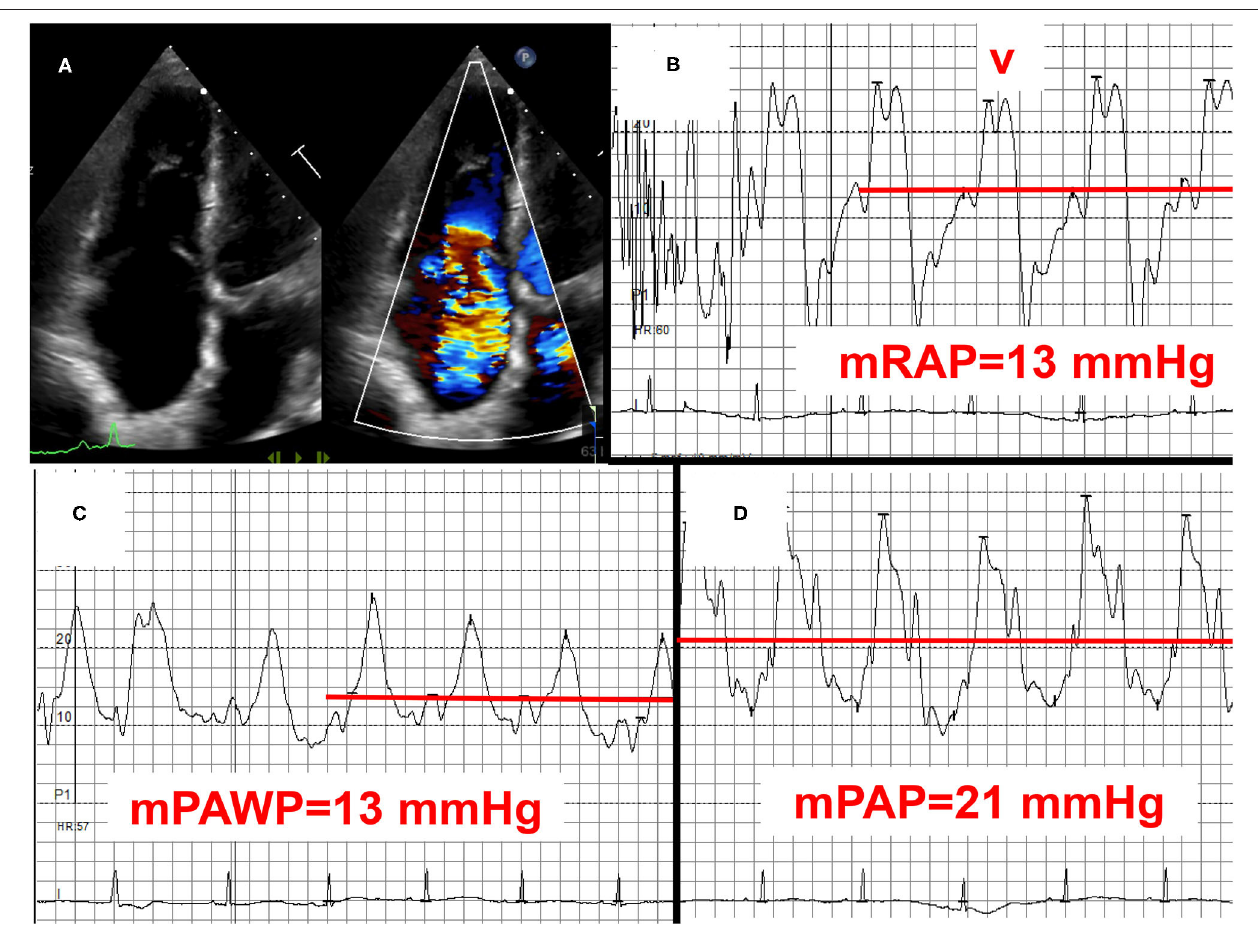
FIGURE 6 | Example 3 of a patient with a mid-range left ventricular ejection fraction (LVEF) and pulmonary hypertension (PH): 83-year old female with permanent atrial fibrillation, previous aortic valve replacement, and coronary artery disease. LVEF 45%, normally functioning aortic bioprothesis, mild to moderate mitral regurgitation, and severe tricuspid regurgitation (A) with signs of right heart failure and high right atrial pressure with high V waves (B) . Mean pulmonary artery wegde pressure (mPAWP): 13 mmHg (C) , mean pulmonary artery pressure (mPAP): 21 mmHg (D) . After coronary angiography (50ml of contrast) rise in mPAWP to 18 mmHg and mPAP to 26 mmHg. The patient has occult post-capillary PH (2016 ESC/ERS definition)/mild post-capillary PH (2018 definition) in the context of left ventricular systolic and diastolic dysfunction. The relatively mild extent of PH does not fully explain right ventricular dilation and severe tricuspid regurgitation. Severe tricuspid regurgitation is most likely the effect of atrial fibrillation predominantly affecting the tricuspid annulus. Management with loop diuretics and spironolactone. The role of transcatheter tricuspid valve repair/replacement has not been defined yet. mRAP, mean right atrial